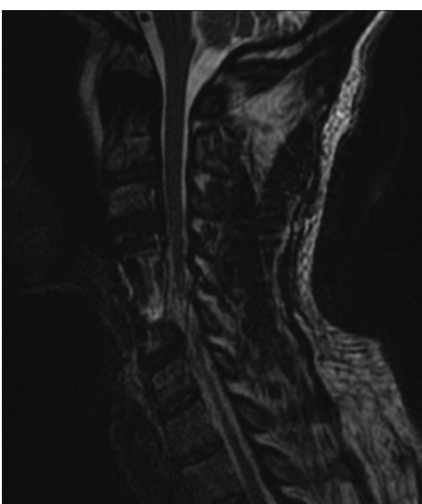
F 4: Day 3 postoperative MRI demonstrates more clearly the spinal cord edema intrinsic to the cord—a “white cord syndrome.”